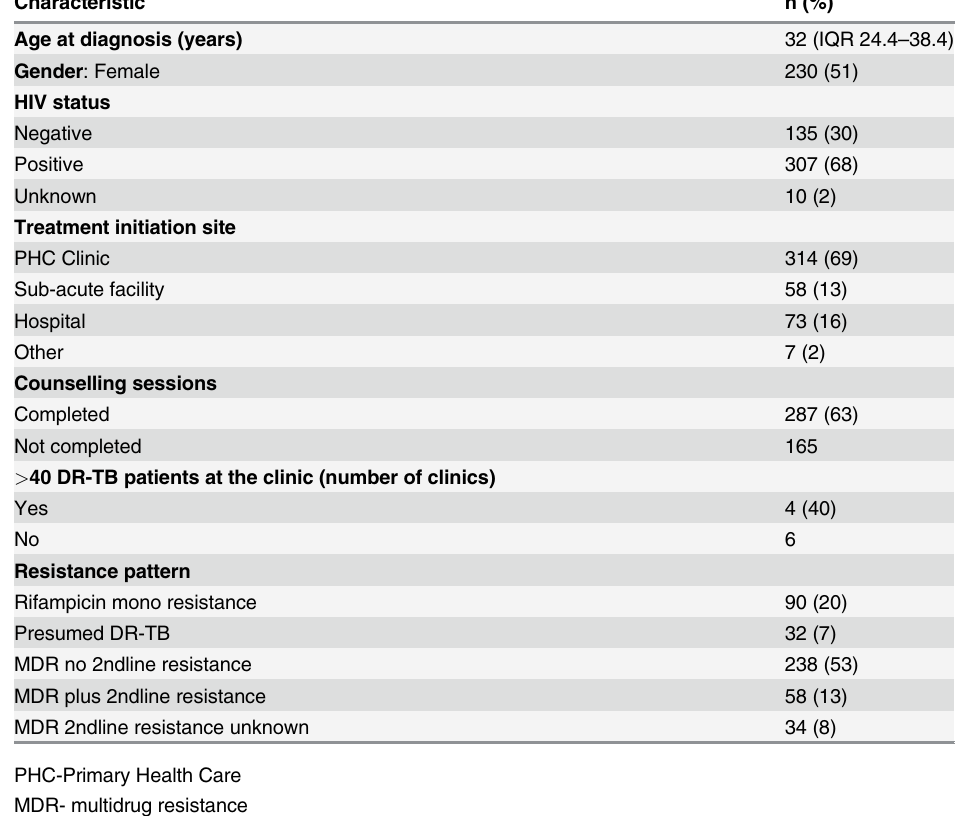
Table 1. Demographic characteristics of patients who started treatment between January 2009 and July 2011 who had treatment outcomes by July 2013 (N = 452).